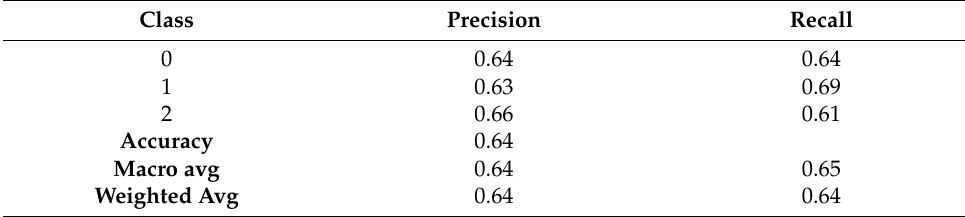
Table 6. Classification report of Decision Trees